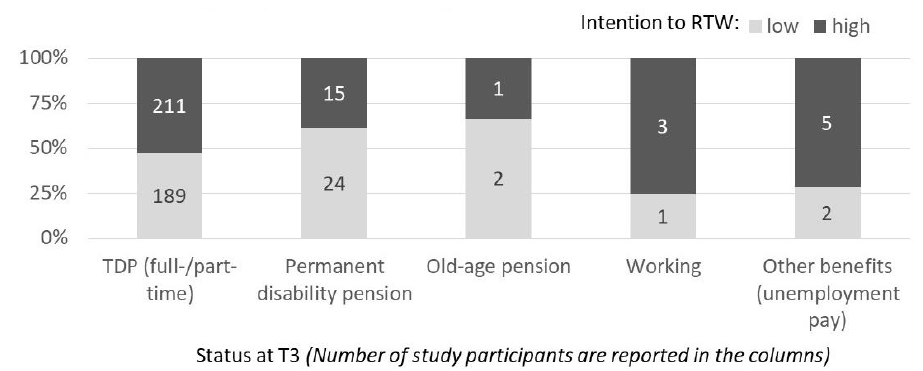
Figure 2. Number of study participants in the different status groups at T3 and their